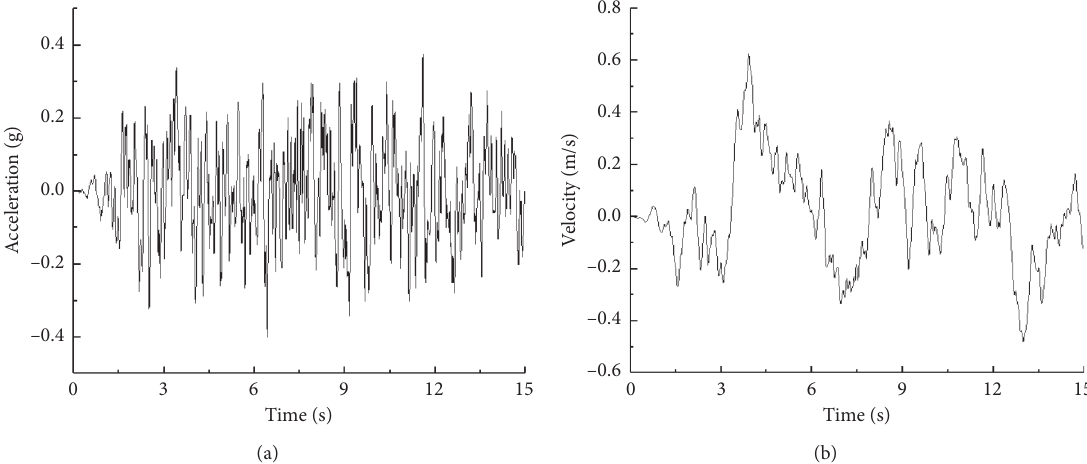
Figure 3: Time history curves of the input seismic wave. (a) Acceleration time history curve. (b) Velocity time history